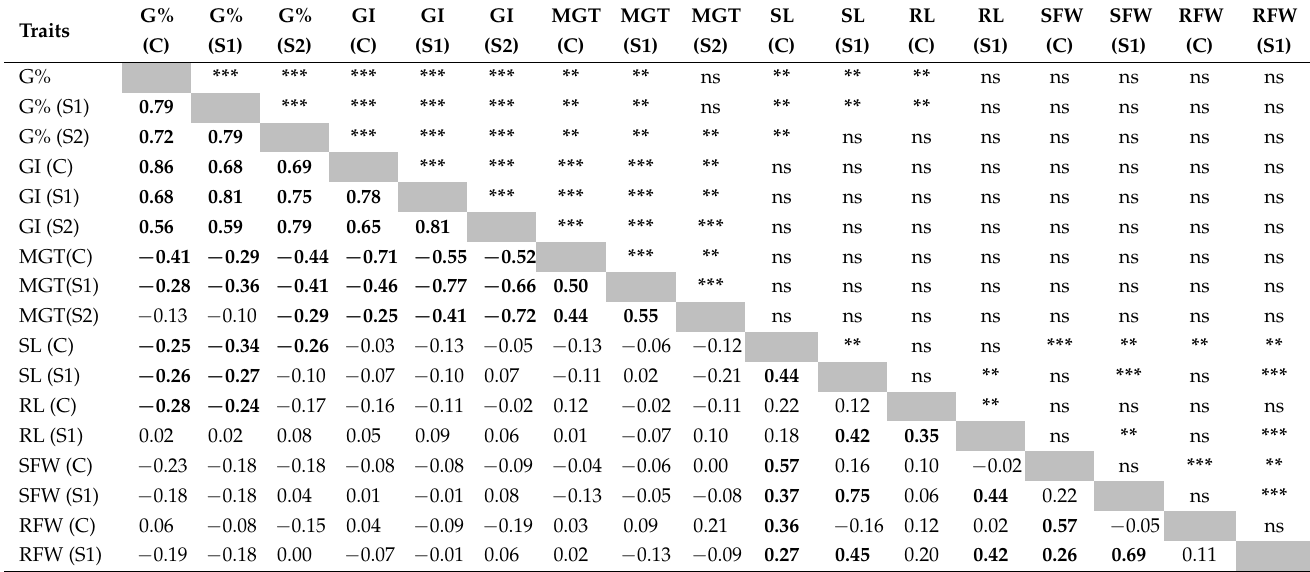
Table 4. Pearson’s correlation matrix (lower left) and their significant levels (upper right) between germination and seedling traits of all barley genotypes evaluated under control and salinity